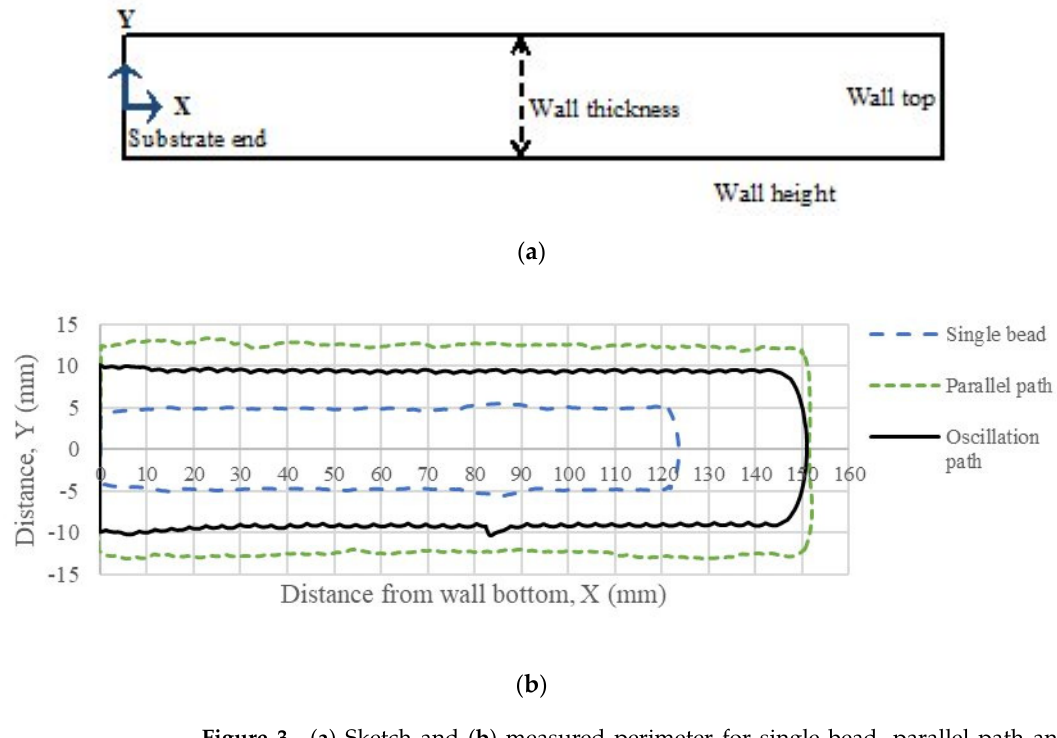
Figure 3. ( a ) Sketch and ( b ) measured perimeter for single bead, parallel path and oscillation path walls.